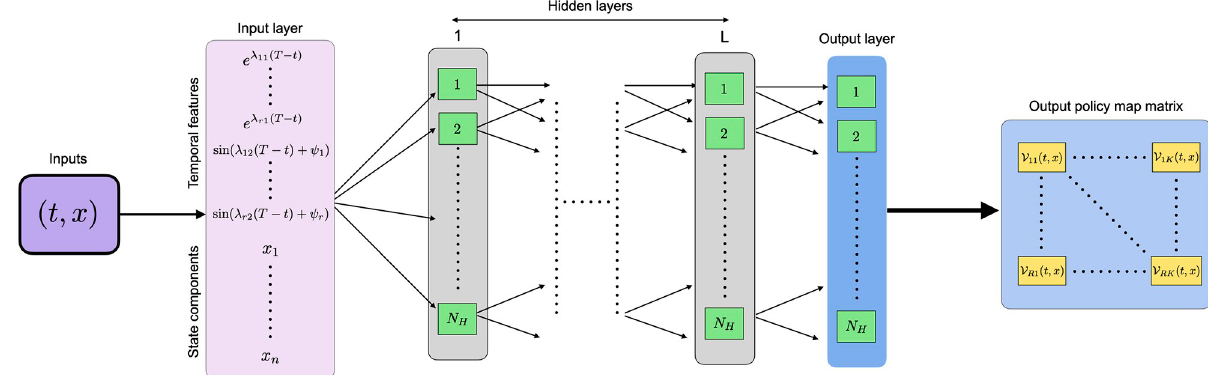
Fig 1. Architecture of the neural network. DNN architecture to encode the matrix-valued map ð t ; x Þ7! V ð t ; x Þ . The inputs ( t , x ) are passed to an input layer, which leaves the state values x unchanged but activates a dictionary of temporal features (26). The resulting output is propagated through a DNN with L fully connected hidden layers, and an additional output layer with each layer having N H nodes. For simplicity, we assume no sparsity in the weight matrices and the bias vectors of these layers. In the final step, the output from the output layer is cast into the policy-map matrix V ð t ; x Þ corresponding to inputs ( t , x ). In Section 4.2 we describe how the loss function can be computed using this matrix-valued map for a batch of stochastic